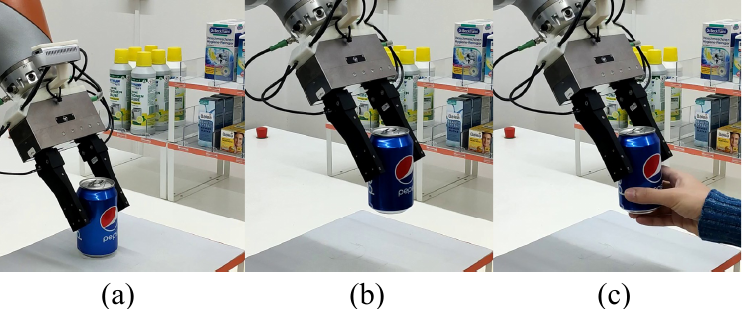
Figure 16. Snapshots of the fourth experiment: ( a ) grasp configuration; ( b ) after lifting; ( c )